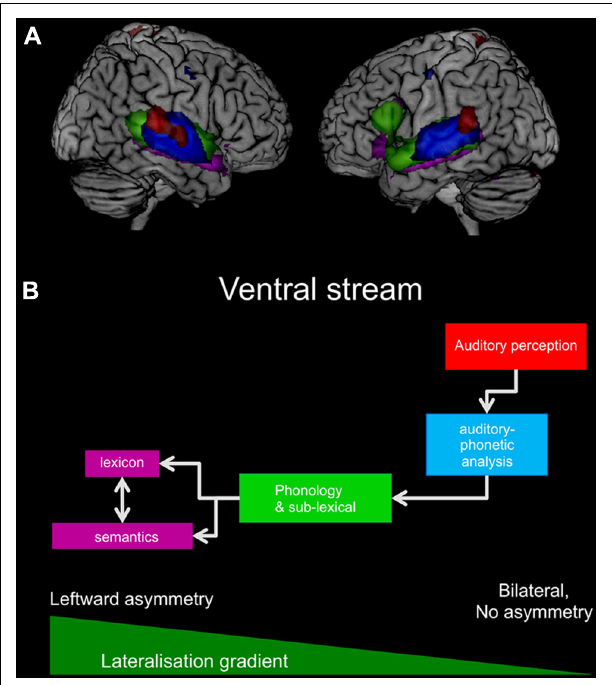
FIGURE 1 | (A) The figure summarizes the results from the presented studies and displays the results for auditory processes of vowels in red, auditory phonetic analysis of consonants in blue, phonological, and sub-lexical processes in green, and, finally, lexico-semantic processes in purple. For display purposes are all results converted into z -scales and projected onto a standard brain. (B) The simplified working model for the ventral stream is displayed with the same colors as in (A) . In addition a lateralization gradient indicates the increasing leftward